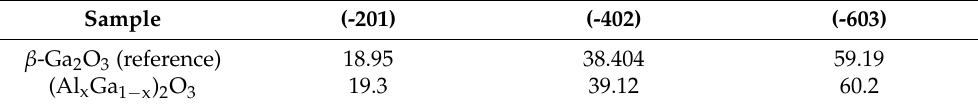
Figure 4. The XRD result of the β -(Al x Ga 1 − x ) 2 O 3 film grown on sapphire substrate ( a ) and the ω rocking curve of (-201) plane for the film ( b ). Table 1. The diffraction peak positions of β -(Al x Ga 1 − x ) 2 O 3 film and the corresponding β -Ga 2 O 3 standard diffraction peak positions.